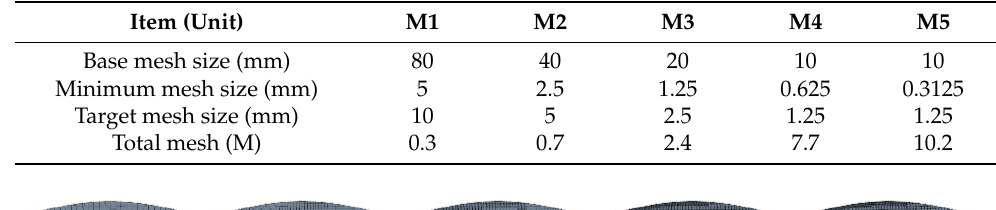
Table 3. Parameters for five groups of meshes.